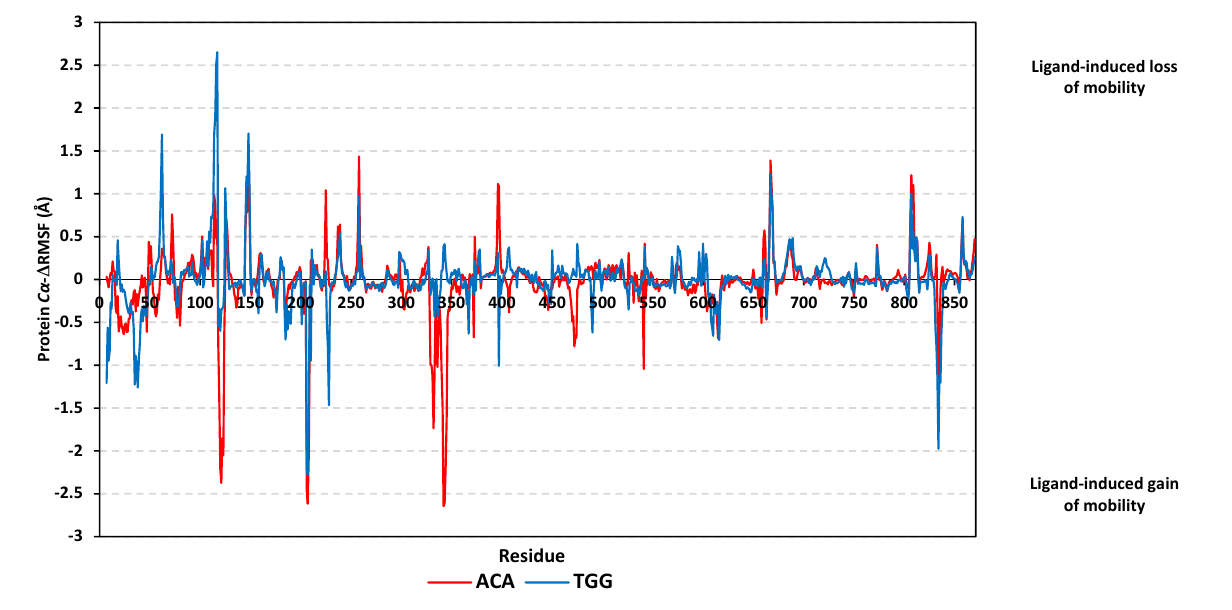
Figure 9. Protein Δ RMSF analysis, in complex with investigated gallotannin derivative and acar- Figure 9. Protein ∆ RMSF analysis, in complex with investigated gallotannin derivative and acarbose, bose, across 200 ns MD simulation run. The Δ RMSF values, in reference to protein backbone C α - across 200 ns MD simulation run. The ∆ RMSF values, in reference to protein backbone C α -atoms, atoms, were estimated and represented in terms of residue sequence numbers. were estimated and represented in terms of residue sequence Table 2. Estimated Δ RMSF a values [Å] for ligand-hMGAM proteins along 200 ns MD simulation. Canonical Domains Form-